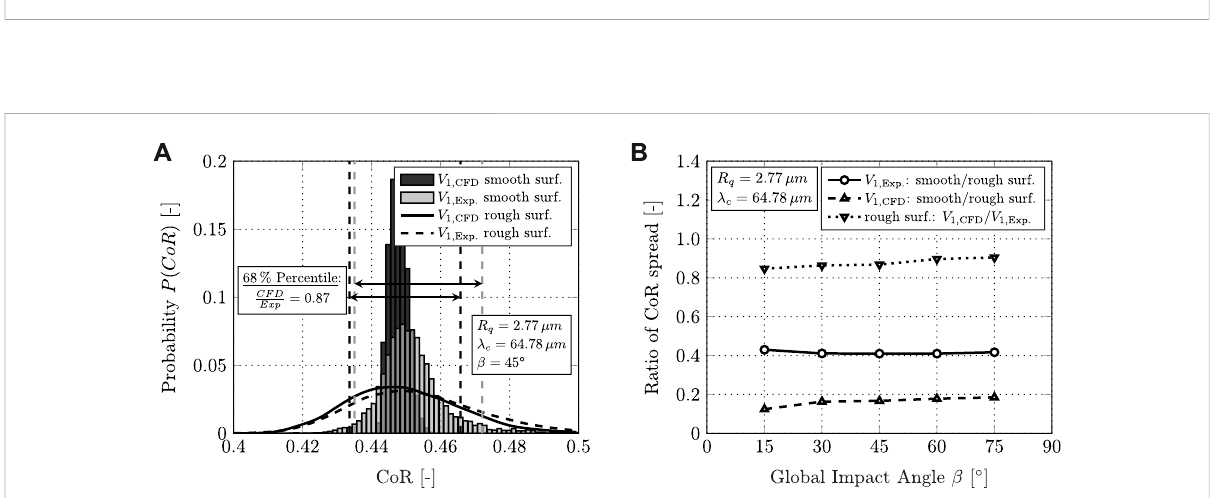
FIGURE 13 Effects on the CoR spread range: (A) in fl uence of the impact velocity distribution on the CoR; (B) ratio of CoR spread range (68% percentile) generated analytically by applying a perfectly smooth and a rough surface for 1) the experimental velocity distribution V 1 , 2) the numerical velocity distribution V 1 , and 3) comparison of CoR spread range generated each for a rough surface but different velocity distributions V 1